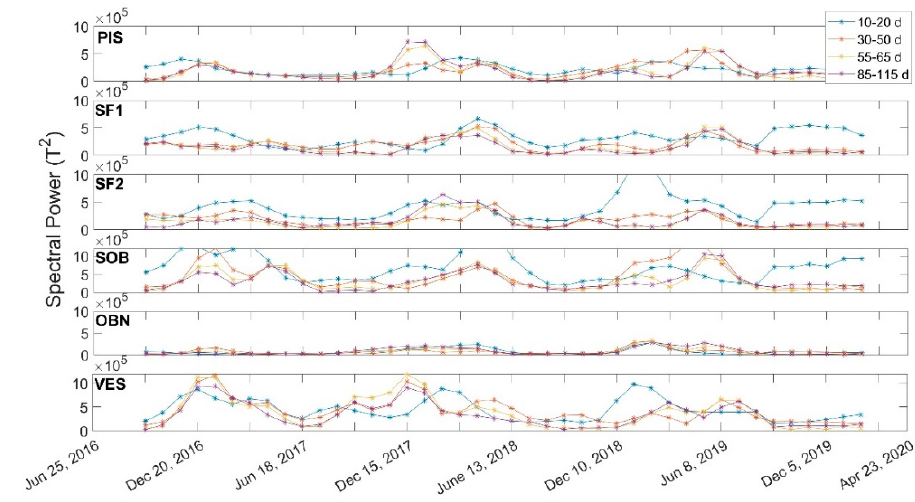
Figure 4. Spectral Power evaluated in the frequency bands (the relative characteristic periods are in the legend). Each point is associated with a half window. Notice how the behavior at all the time scales at Vesuvius is similar to those at CFc in the first part, implying a common exogenous origin.